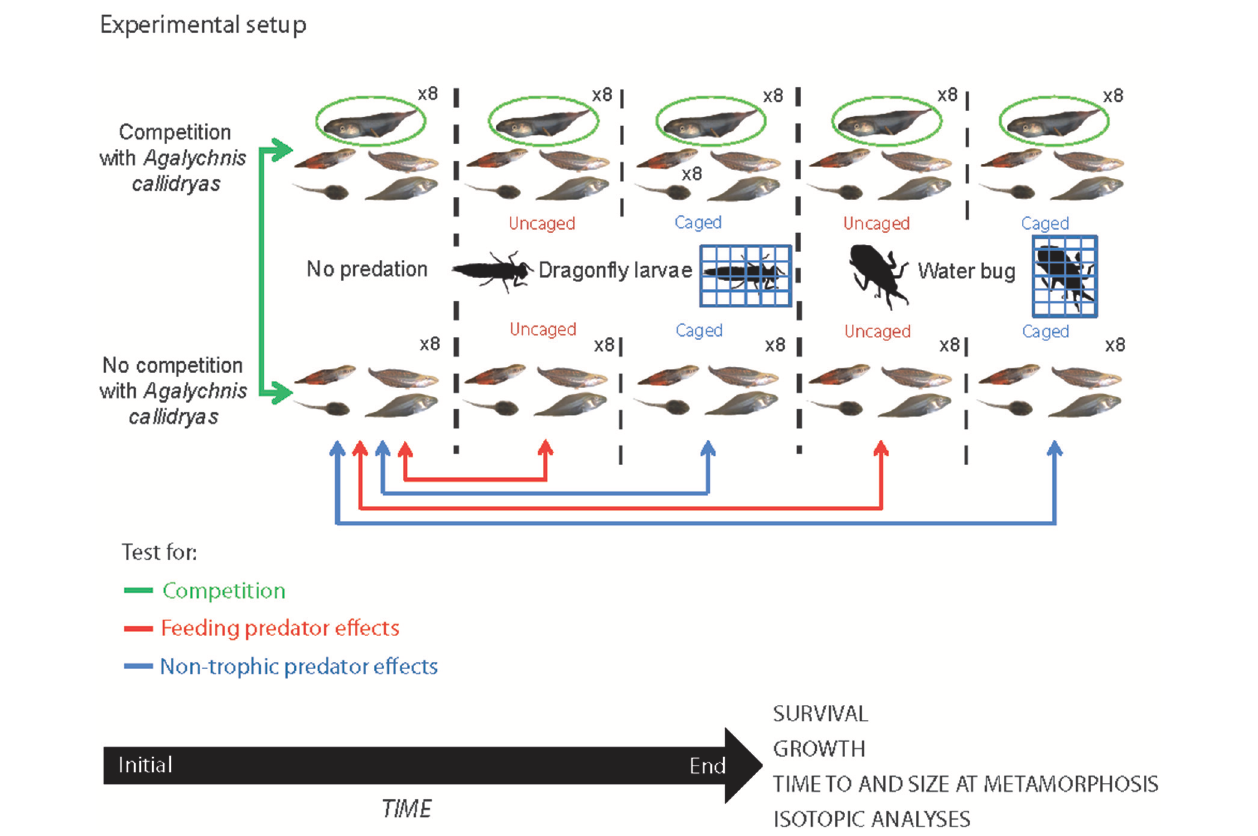
FIGURE 1 | Configuration of the experimental setup used to examine the relative effects of competition and predation on a tropical anuran guild. We manipulated the presence/absence of a potential competitor ( Agalychnis callidryas ) on four other amphibian species (marked in green). We also tested the effect of two types of predators (dragonfly larvae and water bug) on amphibian larvae. We presented the predators either free (uncaged; marked in blue) or caged (marked in red) to test for consumptive and non-consumptive effects of these predators. The experiment lasted 4 weeks and at the end we recorded survival and growth of amphibians, time to and size at metamorphosis, and took tissue samples for isotopic analysis. All tadpole photos by